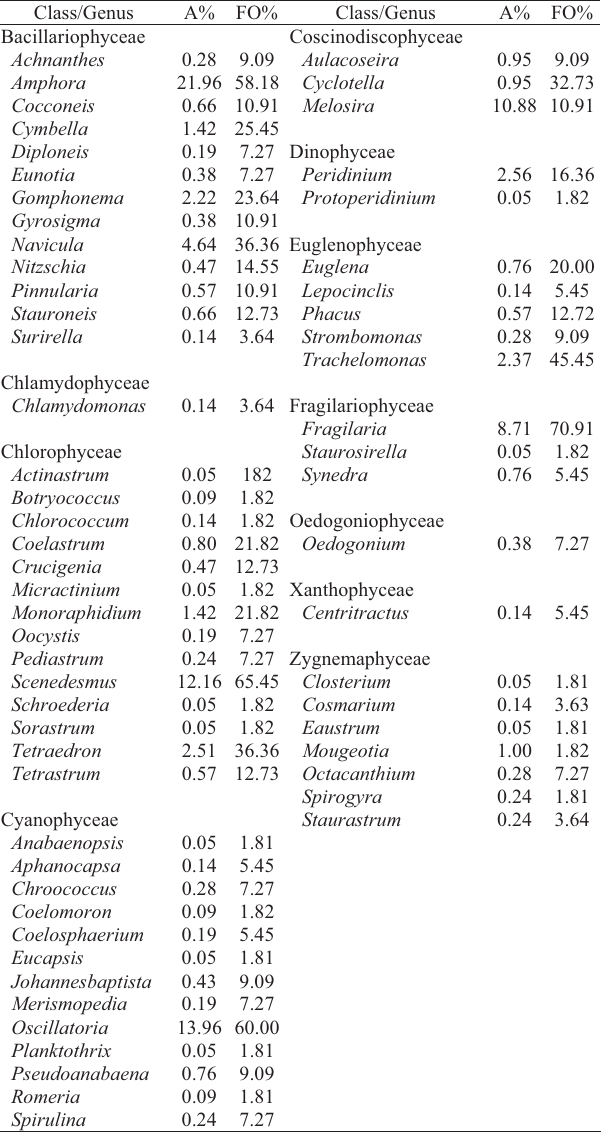
Table 3. Relative abundance (A%) and frequency of occurrence (FO%) of microscopic food items found in the diet of Prochilodus brevis , in aquatic habitats of the Brazilian semi-arid region.